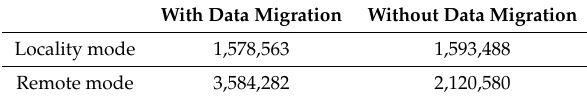
Table 4. Tasks executed in two modes (ms).